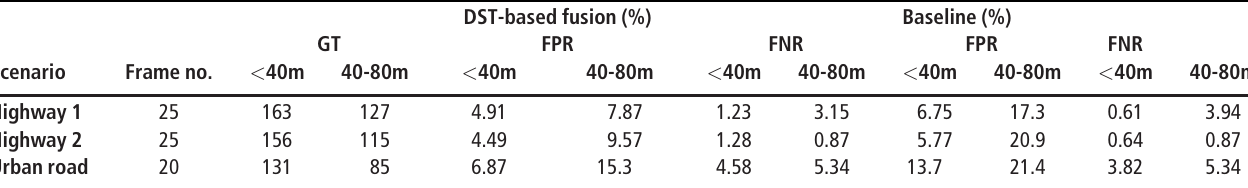
Table II Average results of two approaches with two different ranges in highway and urban scenarios